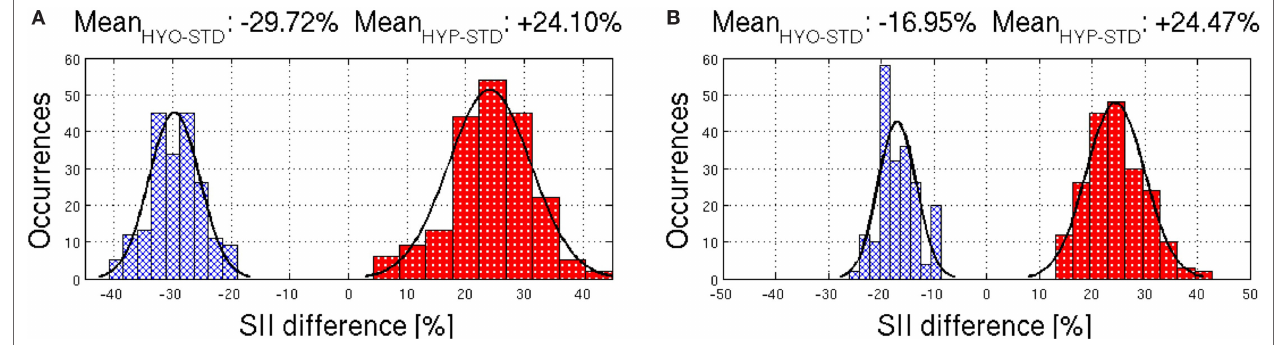
FIGURE 13 | Distribution of the SII differences (in percentage) between hypo and standard speech (HYO-STD blue-crossed histograms), and between hyper and standard speech (HYP-STDred-dotted histograms) for (A) vowels and (B) consonants.